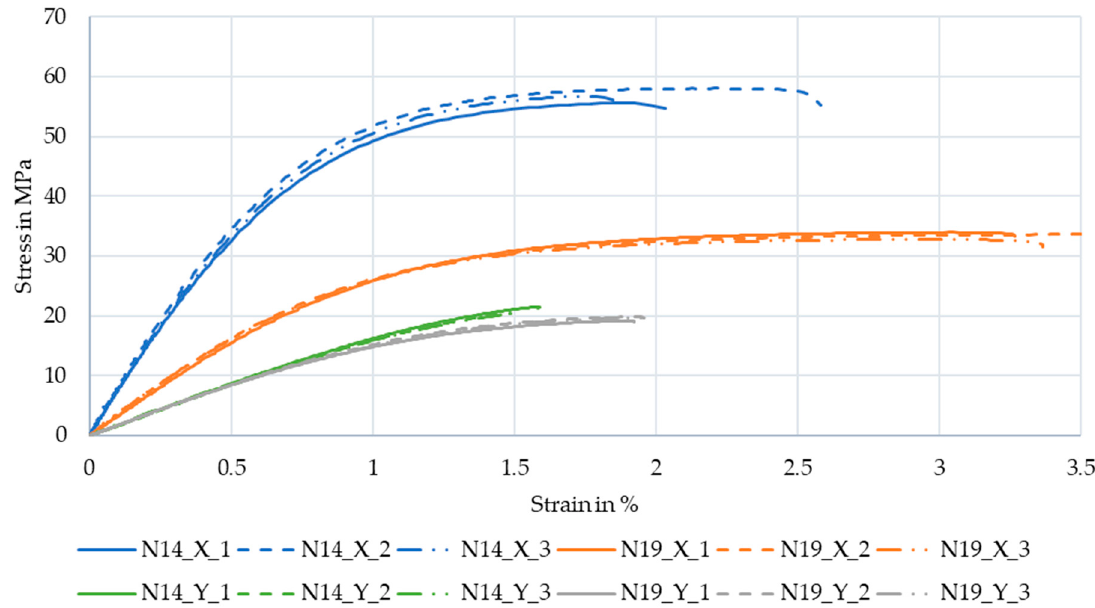
Figure 11. Stress-strain curves of the tensile tests; Legend entries are “experiment number”_”test direction”_”repetition number”.